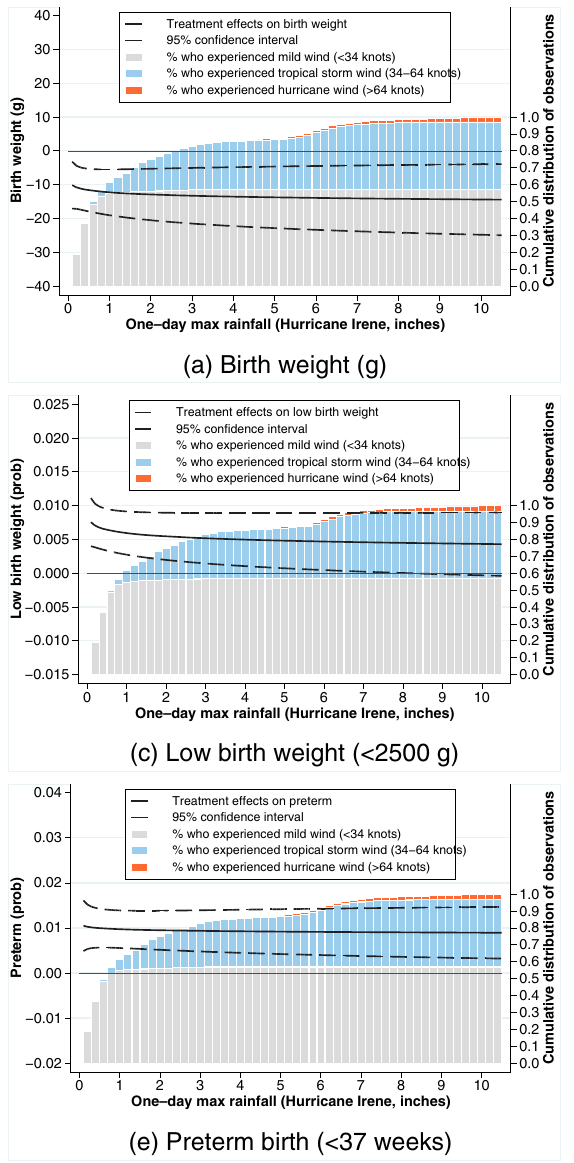
Fig. 1 | Estimated treatment effect of Hurricane Irene exposure on birth out- comes plotted across rainfall intensity at pregnant women ’ s residential addresses. The treatment effects measured for a variety of birth outcomes including: a birthweight(g), b gestationlength(weeks), c binary(0,1)incidenceof low birth weight <2500 g outcomes, d binary (0,1) incidence of very low birth weight <1500 g outcomes, e preterm birth (<37 weeks), and f extremely preterm birth (<34 weeks). Treatment effects were estimated against a baseline of births from the same zip code that occurred with expected delivery dates within the